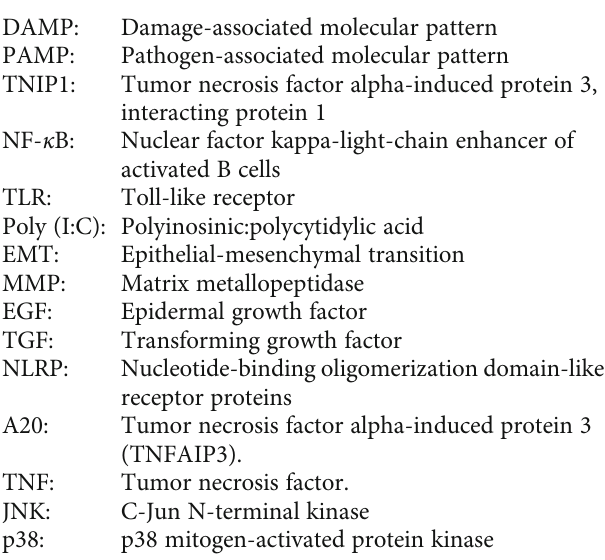
Supplementary Table 1: qRT-PCR primers. Supplementary Figure 1: (a) transfection and treatment timeline. (b) Repre-